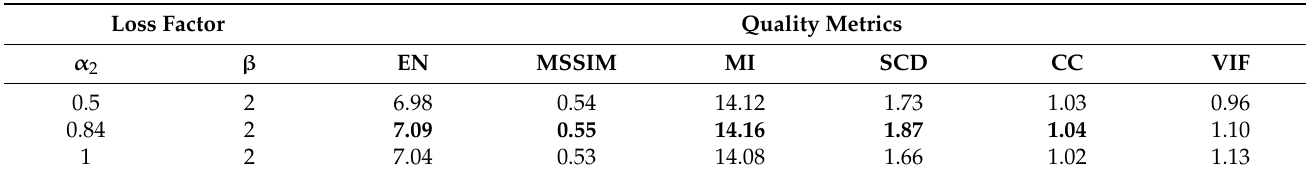
Table 5. Ablation studies on changing loss factor α 2 while maintaining β = 2. Bold represents for the best result in